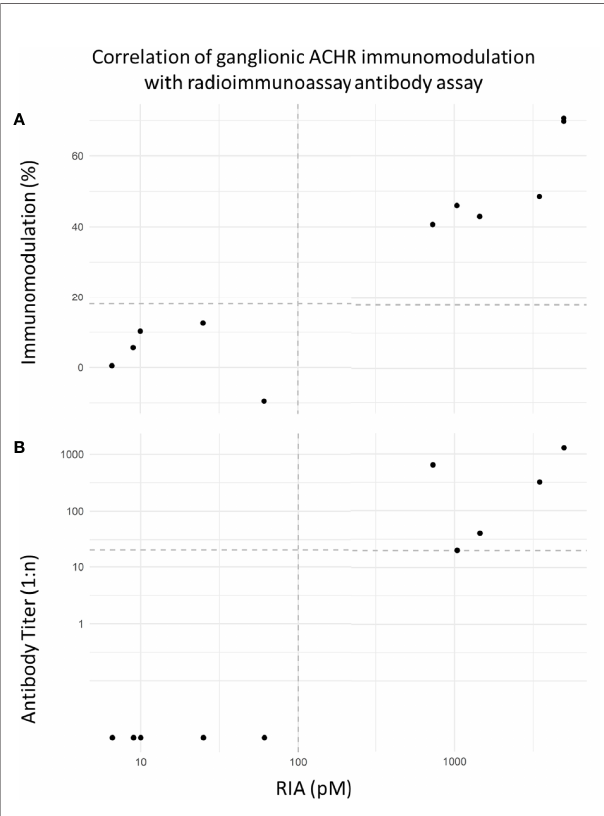
FIGURE 3 | Flow cytometric gnACHR modulation by patient autoantibodies. (A) Immunomodulation at screening dilution of 1:20. (B) Endpoint Titer of results (results with <18% immunomodulation being considered “ Not Detected ” ). ( C – inset) Receiver-Operator Characteristic (ROC) curve for all radioimmunoassay con fi rmed seropositive AAG serum samples, compared to all expected negative samples (Healthy Controls, Autonomic Disorders, Other Neurological Disorders and Systemic Lupus Erythematosus). Aurea Under ROC (AUROC) = 1).